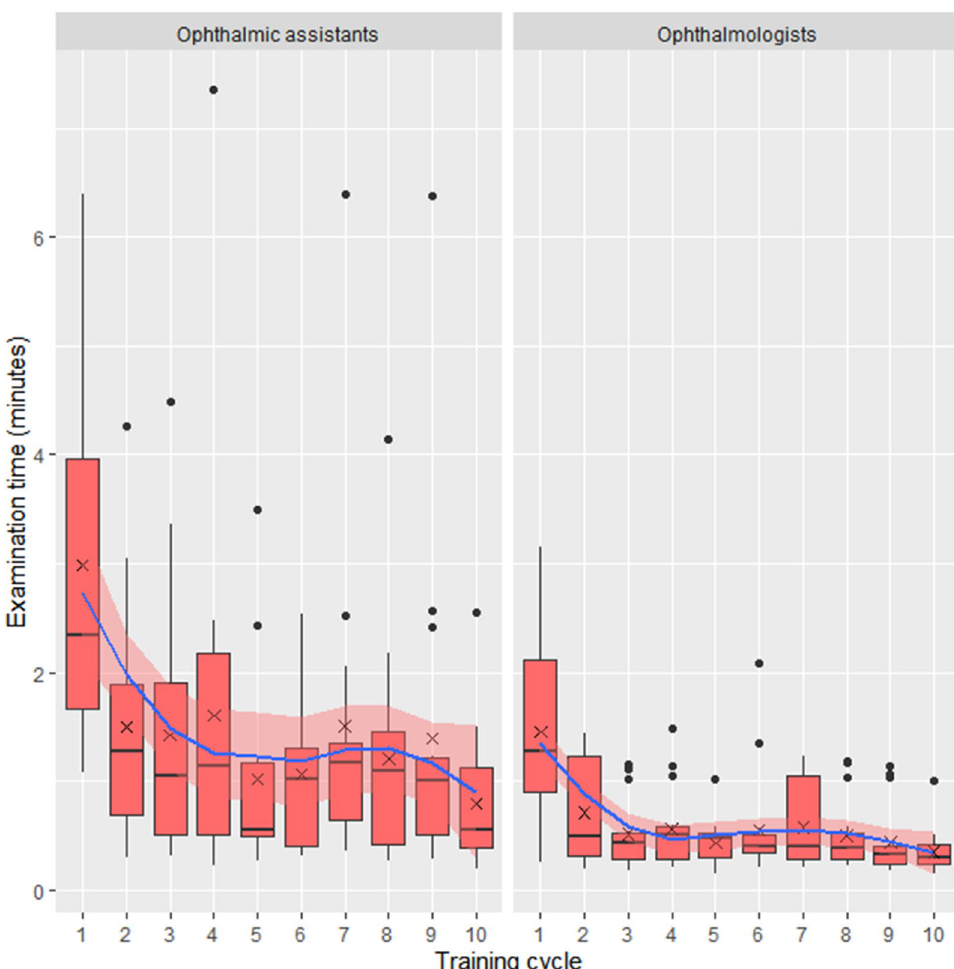
Figure 4. Effect of training on examination time-ophthalmic assistants versus ophthalmologists. Boxplot values over 1.5 interquartile range below the first quartile or above the third quartile were defined as outliers. Crosses indicate the mean. The blue line indicates a local polynomial regression fitting with 95% confidence intervals in light